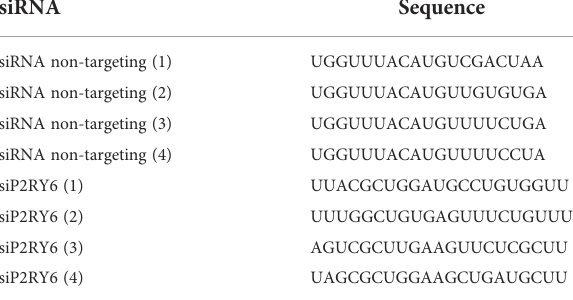
TABLE 2 Sequences of the different small interfering RNAs (siRNAs).